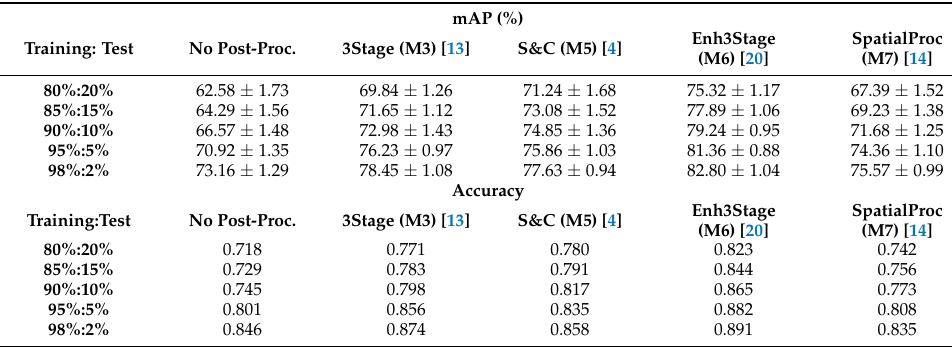
Table 9. Mean average precision and accuracy when post-processed by each of the four schemes (M3, M5, M6 and M7) on the online VEDAI dataset. mAP